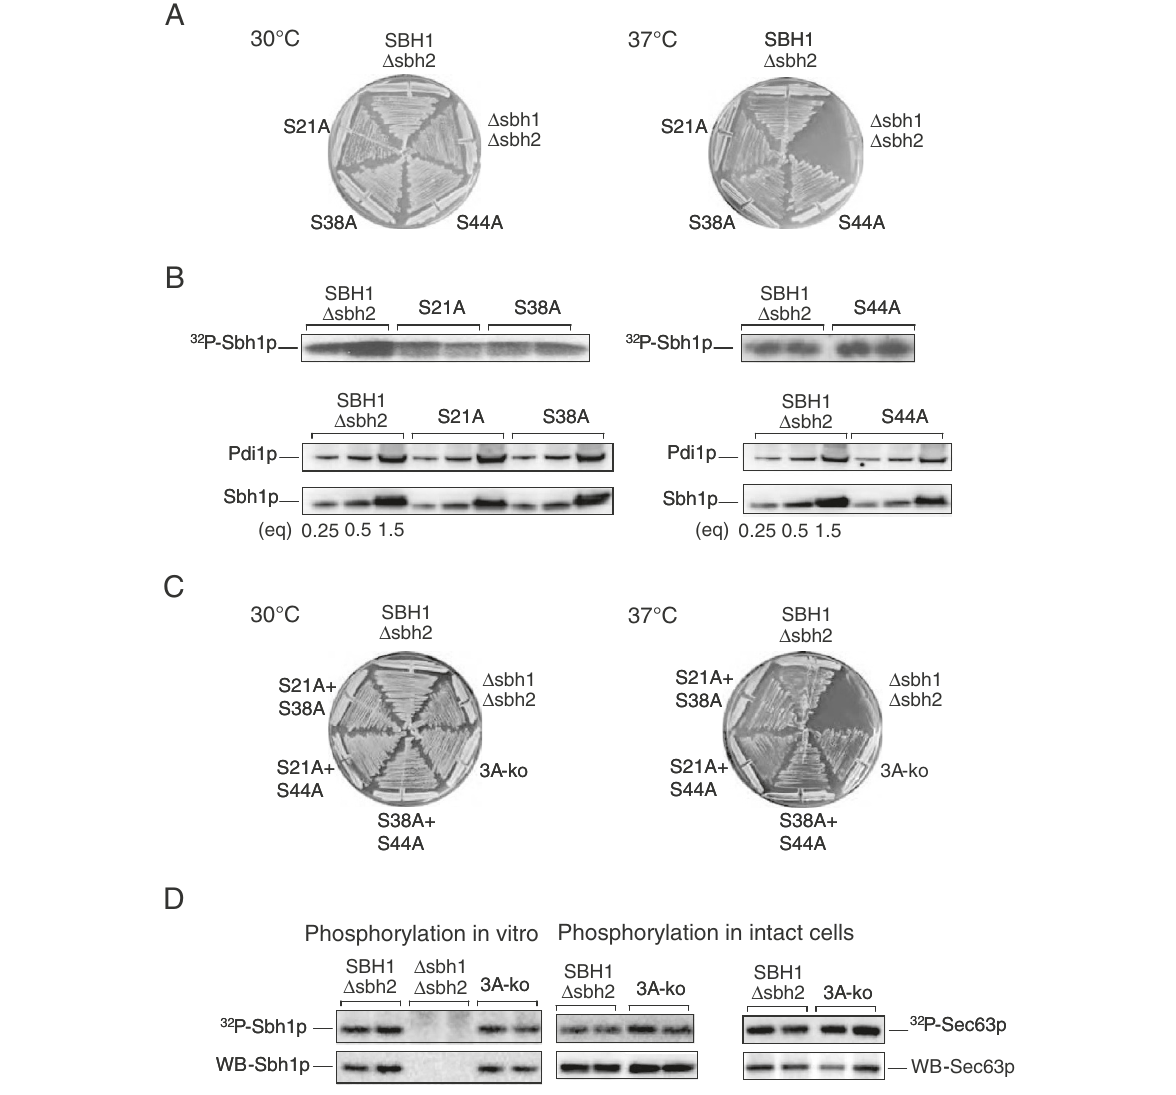
Figure 2 Mutation of the predicted phosphorylation sites in Sbh1p. ( A ) The indicated sites were mutated to alanine, and mutants expressed in a Δ sbh1 Δ sbh2 strain. SBH1 Δ sbh2 yeast were used as a control. Strains were grown on YPD plates at 30°C and 37°C for 2d. ( B ) Upper: Membranes from the indicated strains were labelled with gamma γ -[ 32 P]ATP and Sbh1 proteins analyzed as above. Lower: The indicated amount of microsomes was dissolved in SDS sample buffer, proteins separated by gel electrophoresis and Sbh1p and Pdi1p (as a loading control) detected by immunoblotting. ( C ) As in (A). ( D ) Sbh1 mutant proteins from strains shown in ( C ) were either labelled with g-[ 32 P]ATP in microsomes as above (left panel), or labelled in intact cells with [ 32 P]phosphate; proteins were immunoprecipitated, separated on 15% SDS gels, and detected by autoradiography. Sec63p was used as a control phosphoprotein. Immunoprecipitated proteins were also detected by immunoblotting (lower